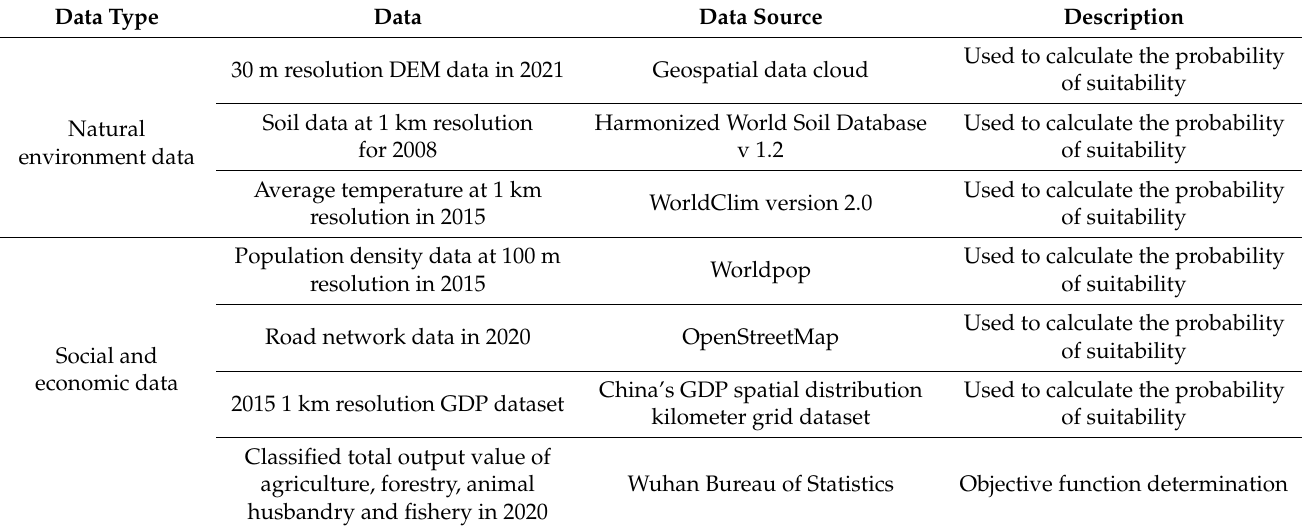
Table 1. Research data and their